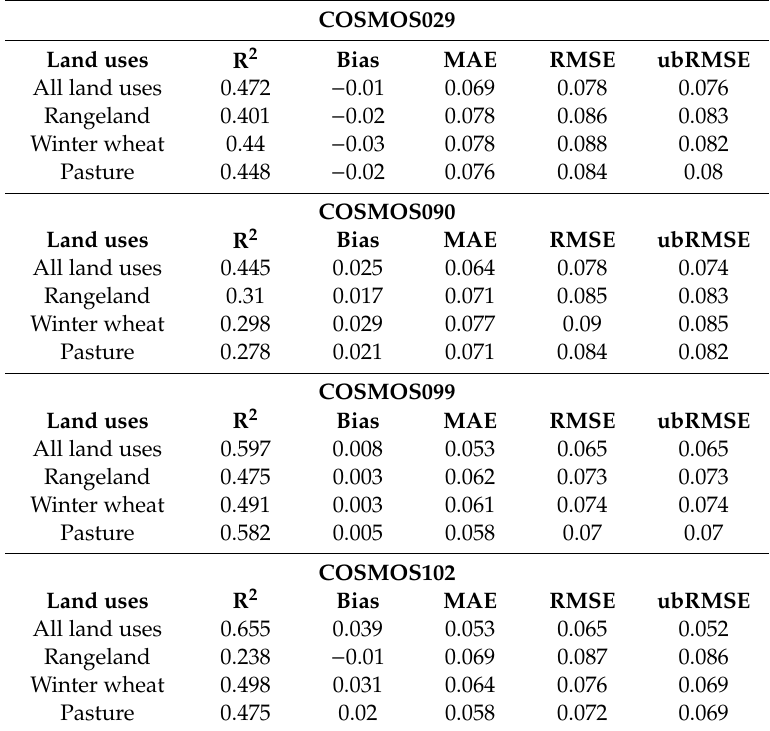
Table 4. Soil moisture error metrics using di ff erent parameter values in the water cloud model for A, B and α . The parameter values are determined for di ff erent land uses according to Table 4 in Bindlish and Barros